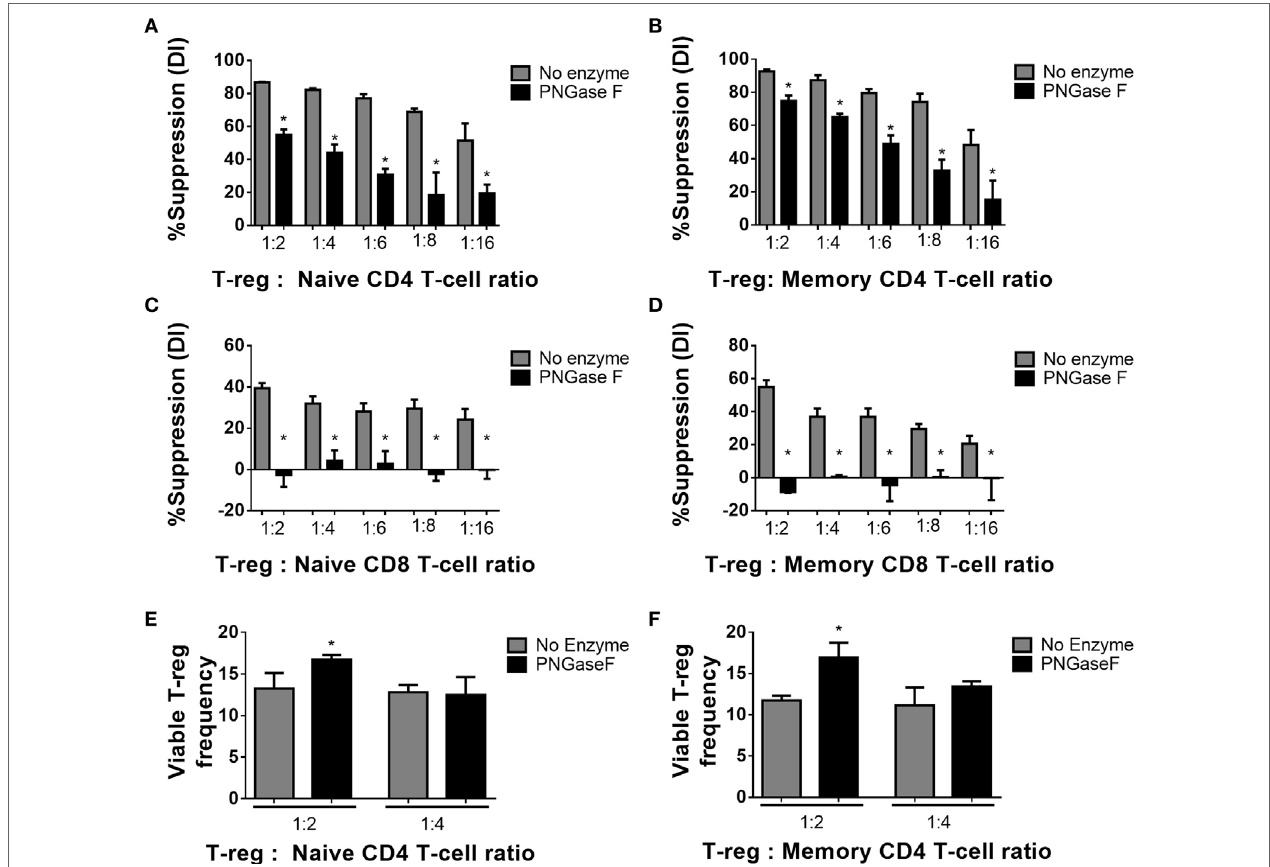
FigUre 6 | Manipulation of murine Treg surface N -glycosylation impairs suppressive potency. (a) Naïve and (B) memory CD4 + Tconv and (c) naïve and (D) memory CD8 + Tconv were cocultured in the presence of CD4 − CD8 − antigen presenting cells and no enzyme or PNGase F-treated Treg populations at Treg: responder T-cell ratios of 0:1, 1:2, 1:4, 1:6, 1:8, and 1:16 for 4 days with anti-CD3 stimulation. Suppressive function was quantified based on responder T-cell division index (DI) after 4 days and presented as the calculated percent suppression [%Suppression (DI)]. (e,F) Day 4 frequencies of viable Treg were expressed as percentages of the total viable cells (Viable Treg frequency) in the cocultures with (e) naïve and (F) memory CD4 + responder T-cells. Data represent mean ± SD ( n = 3 technical replicates). Results were confirmed in three independent experiments. Statistical analysis was performed by permutation test with an unpaired design comparing the coculture with the different Treg populations to the no Treg condition (* p value ≤